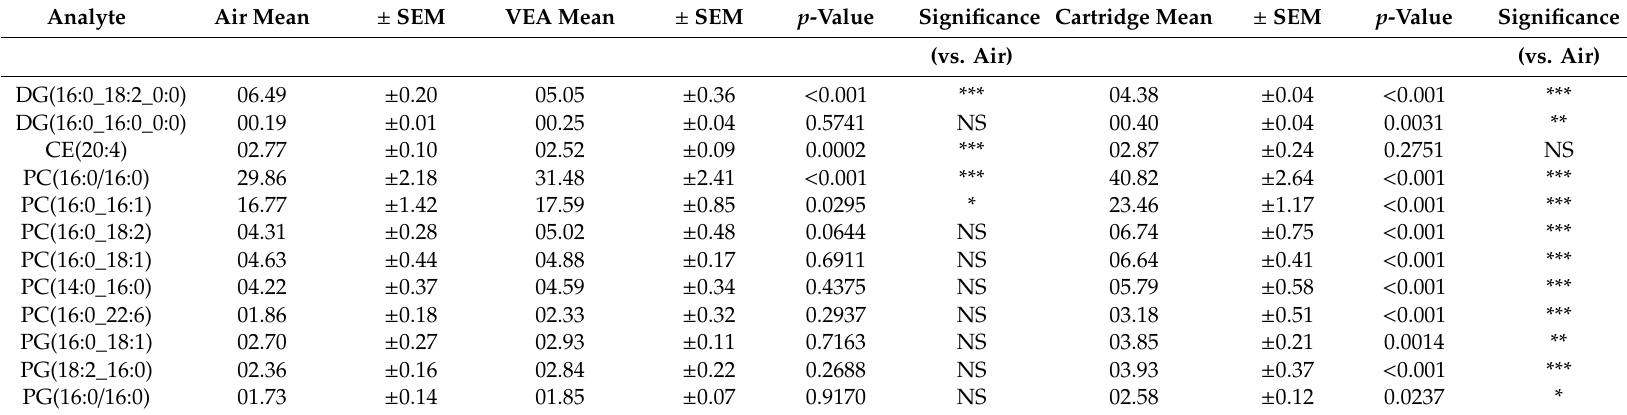
Table 1. Untargeted lipidomic analysis (DG: diradylglycerols, CE: sterols, PC: glycerophosphocholines) in bronchoalveolar lavage fluid from air, vitamin E acetate (VEA), and cartridge-aerosol-exposed